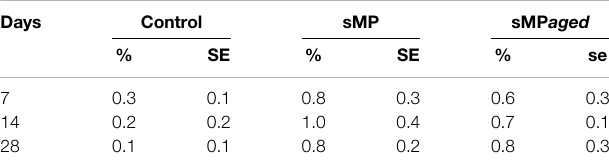
TABLE 2 | Relative abundance of sMP/sMP aged in periphyton over time, measured by FC and